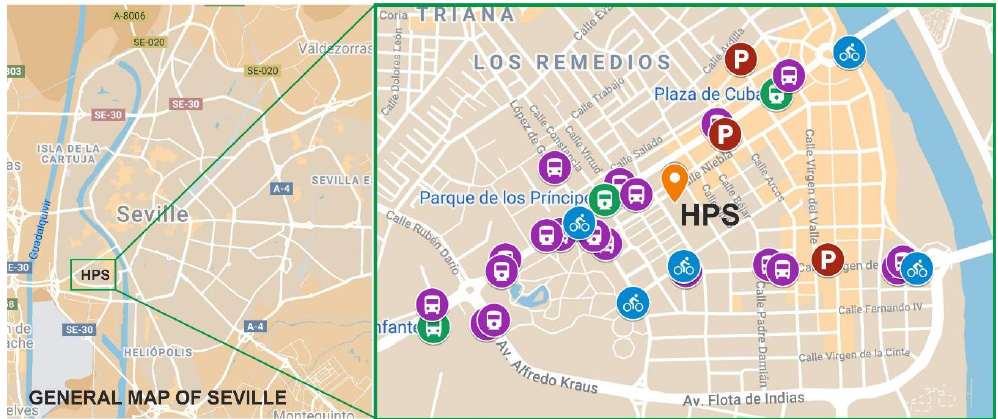
Figure 11. Georeferenced analysis of the HPS campus [32,33].